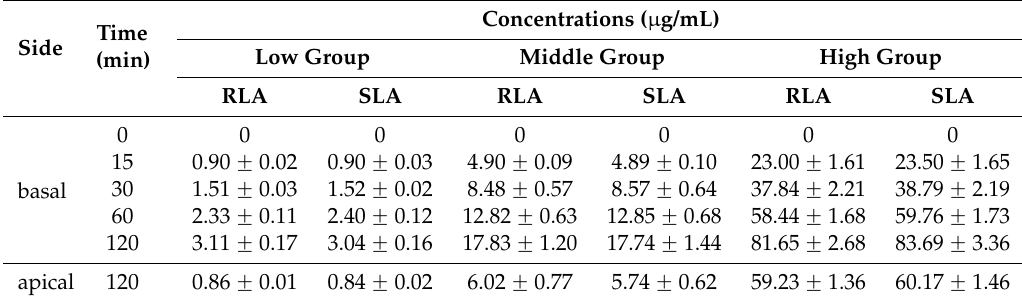
Table 3. The concentration-time profiles of α -lipoic acid after addition to the apical side of Mardin-Darby canine kidney II cell.